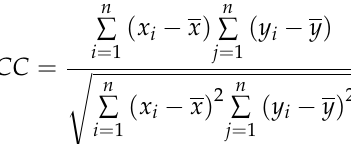
syncline, Qijia anticline, and Shijiadian syncline in order from north to south. The coal- bearing stratum in the study area is the Jurassic Middle Yan’an Formation, with a total of six coal-bearing seams, of which No. 4 coal is a relatively stable and main mineable coal seam in the minefield, distributed throughout the minefield. The stratigraphic occurrence and structural morphology show that the strata above Jurassic in this area have not been subjected to strong tectonic extrusion and deformation. The structure is closely related to the coal system, the deposition distribution of coal seams and their thickness changes. The coal seam is thicker at the syncline axis and thinner at the anticline axis. This pattern is mainly related to synsedimentary tectonics, and also reflects the inheritance of later tectonics. Figure 2. Structure characteristic of the study area. CBM proved resources/reserves of the study area are 35.89 × 10 8 m 3 , which are 25.5 × 10 8 m 3 in the No. 4 coal reservoir, and the average resource abundance is 1.44×10 8 m 3 /km 2 .